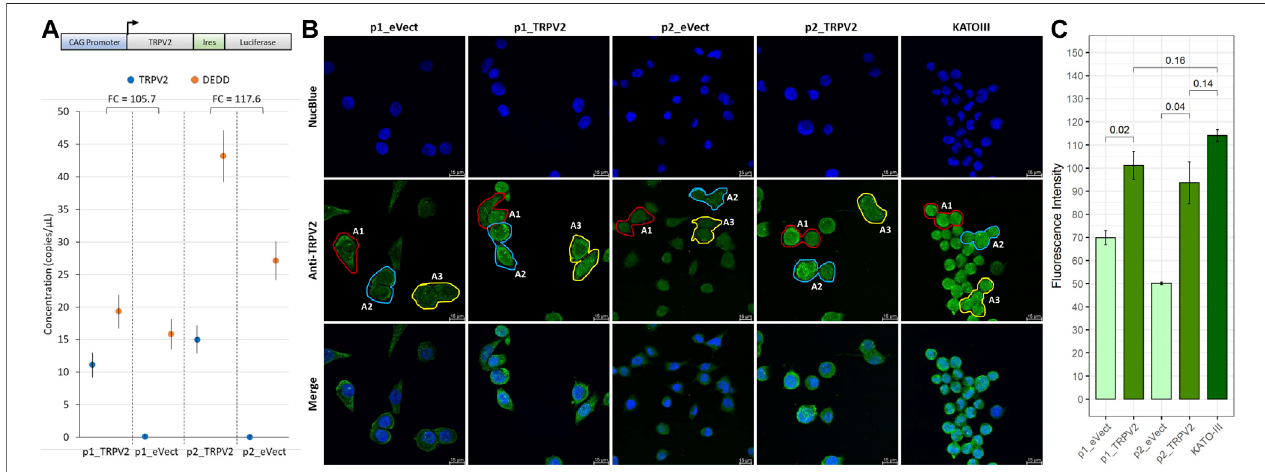
FIGURE 5 | Exogenous expression of TRPV2 calcium channel in cisplatin-sensitive GC cell line. (A) Schematic representation of TRPV2 expression construct and evaluationof TRPV2 overexpressionby ddPCR. (B) Representative images ofTRPV2 exogenousexpression byconfocal microscopyin transformed AGS cellline pools as compared with the KATO-III cell line. (C) Quanti fi cation of TRPV2 expression in cells carrying the empty vector (p1_ and p2_eVect) or TRPV2 CDS (p1_ and p2_TRPV2) and comparison with KATO-III as reference. t -test on mean fl uorescence intensity from three areas (A1, A2, and A3) was used for comparisons. Confocal specimen staining: NucBlue, rabbit anti-human TRPV2 revealed with goat anti-rabbit IgG-FITC; magni fi cation: × 63; Leica SP8 microscope.